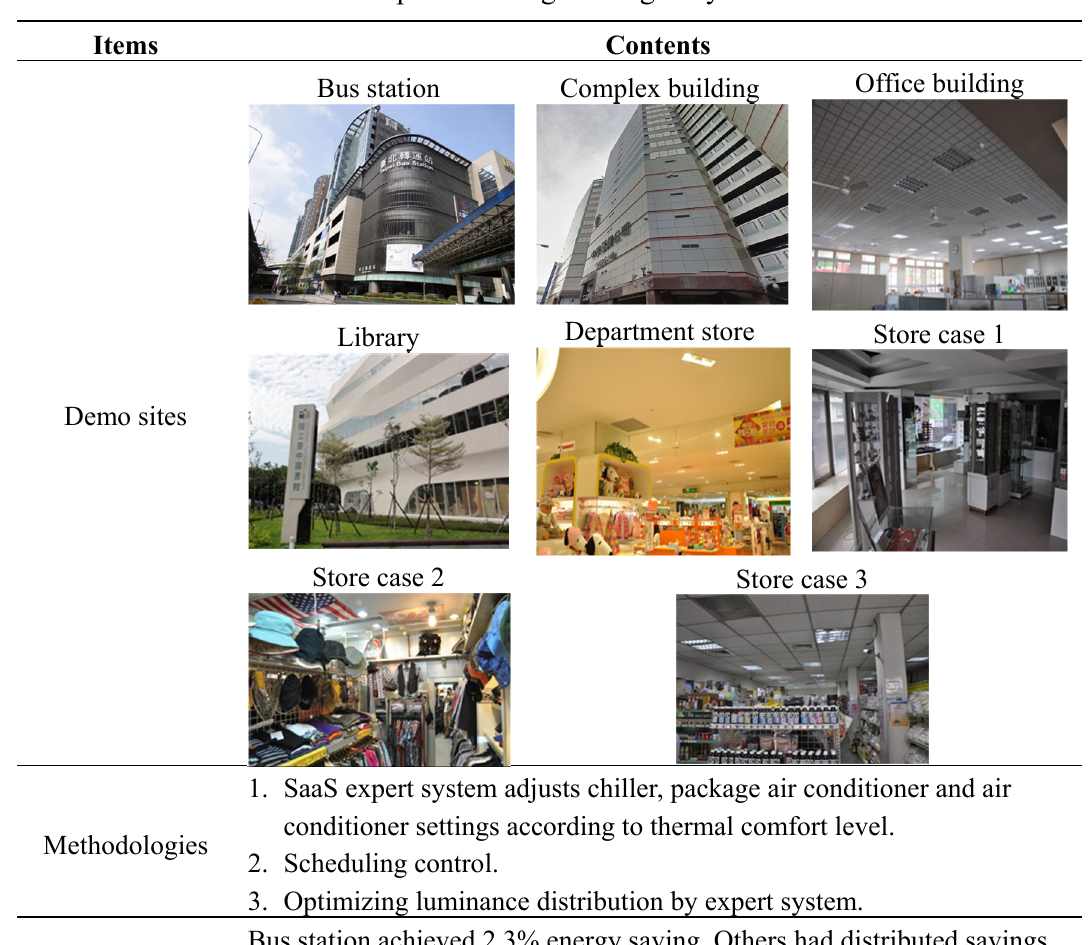
Table 5. Complex buildings managed by cloud